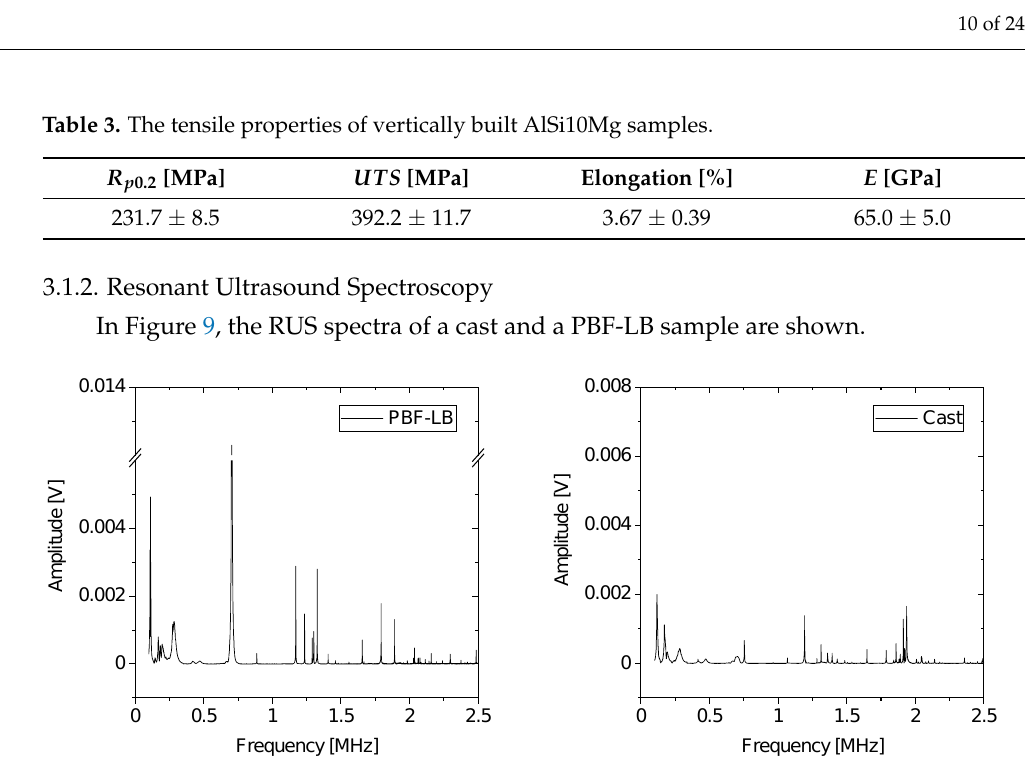
Figure 9. RUS spectrum of a sample fabricated in the PBF-LB process ( left ) and of a cast AlSi10Mg sample ( right ).